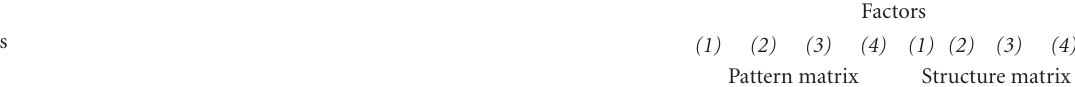
Table 5: Pattern and structure matrix for PAF with an oblimin rotation of the four-factor solution of patient participation in decision making in surgical treatment items. N = 1 . 022.